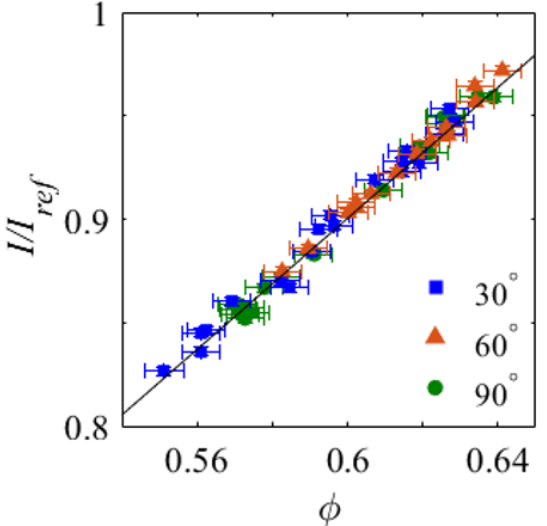
Fig. 2. Normalized signal intensity vs solid